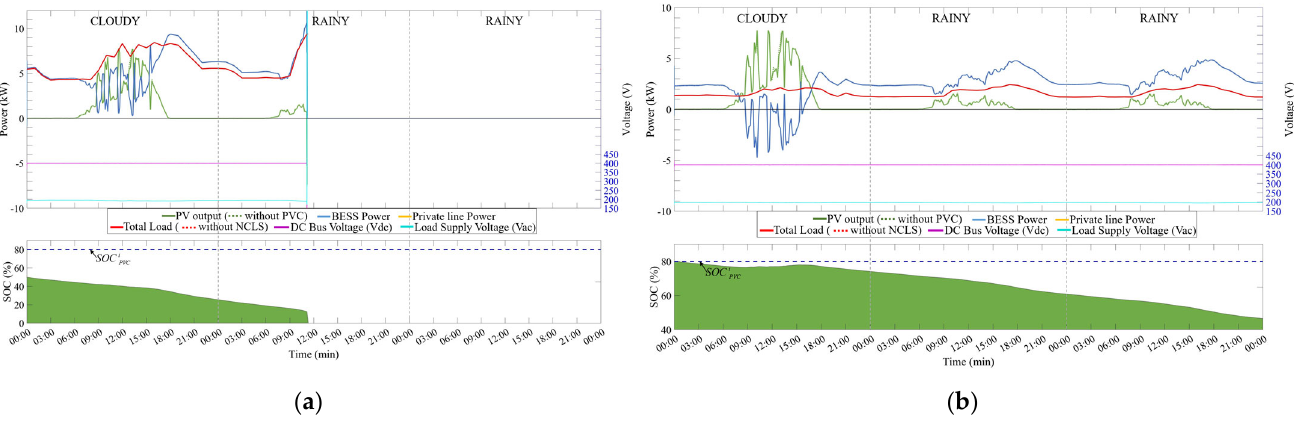
Figure 10. Test case 1 (disconnected). ( a ) Performance of prosumer X. ( b ) Performance of prosumer Y. Positive BESS power indicates discharge in the power flow curve for each figure, whereas negative power denotes BESS charging. Similarly, positive private line power values signify power flow from the private line, whereas negative flow means power flow towards the private line from the